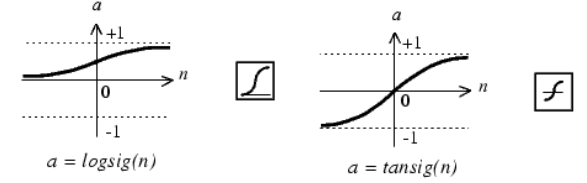
Fig. 3. Two classical nonlinear activation